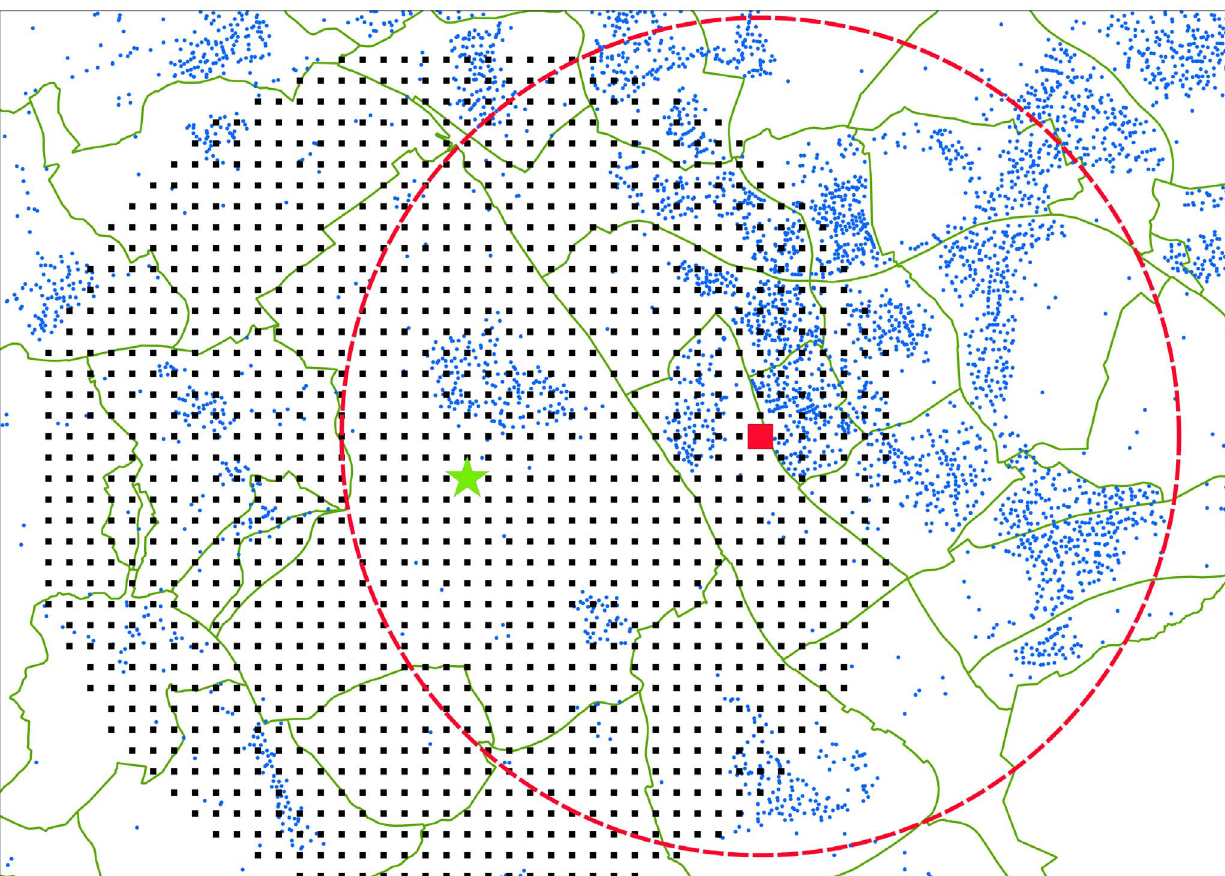
Figure 1. Overview of the data selection in outbreak area C. The PC4-polygons are indicated by the green lines. The center of the case cluster is indicated by the green star. This star is also the center of the spatial grid with a resolution of 250 6 250 m (black squares). Around each of the grid points (example indicated by the large red square) the distance r to all PC6’s (small blue dots) within Z =5000 m is determined, as well as the number of cases k and inhabitants n in these PC6’s.